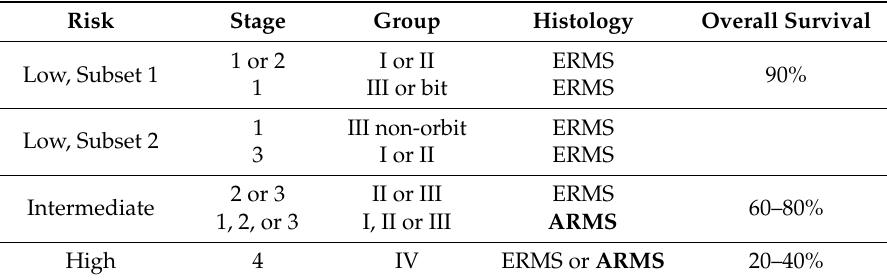
Table 3. Risk Group Stratification for Rhabdomyosarcoma.